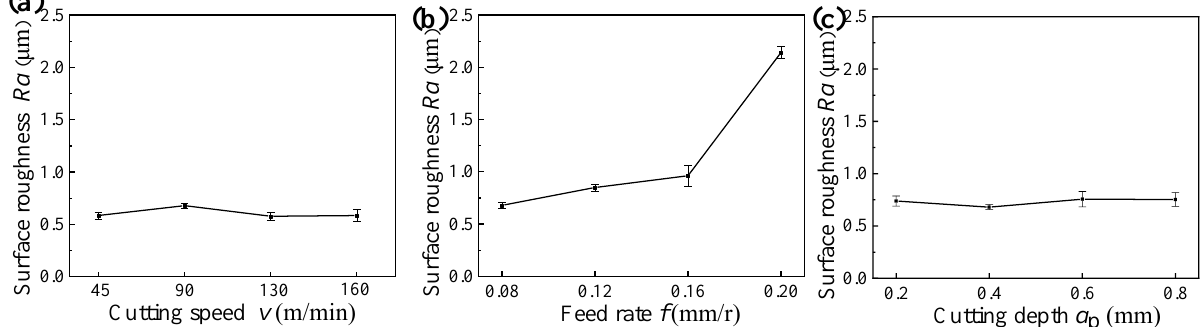
Figure 3. Surface roughness of samples machined under different cutting parameters: ( a ) cutting speed, ( b ) feed rate, and ( c ) cutting depth.